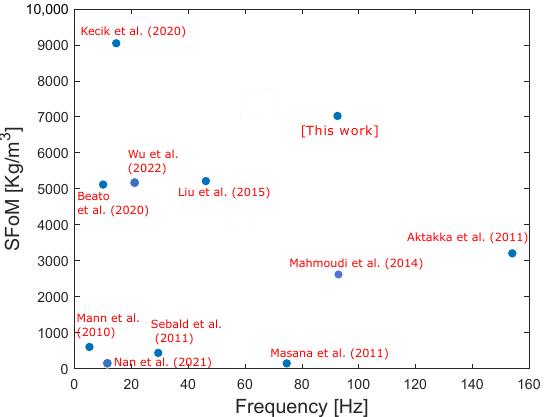
Figure 5. Comparison of the proposed harvester SFoM with the current state-of-the-art [35,56–64]. The harvested energy from the hybrid structure needs to be stored to power small consumption devices. As the harvester output signals are alternating (AC), they need to be transformed to direct ones (DC) before being stored. Accordingly, an energy storage circuit including the rectifier, the filter, and the signal regulator is designed. The energy acquisition and storage circuit diagram are depicted in Figure 6a. This storage test is a proof of charging. For that, we have chosen, at present, to store the output of one PE element (the right patch clamped to the bottom beam). The outputs are connected to an electronic module to rectify, filter, and then regulate the signals. The practical value of the diodes threshold voltage is of 0.2 V. After being regulated, the electrical harvested voltage is stored in 100 µ F capacitor. In the experiment, the voltage is recorded by an acquisition card when the harvester is vibrating. As seen in Figure 6b, the maximum voltage obtained is of 0.44 V. The evolution with time on this load capacitor in the charging and discharging phases is illustrated in Figure 6c. The maximum voltage across the capacitor is of 0.38 V. It is shown that the stored battery voltage rises from 0.02 V up to 0.33 V in 1 min under a basis excitation of 0.7 g .